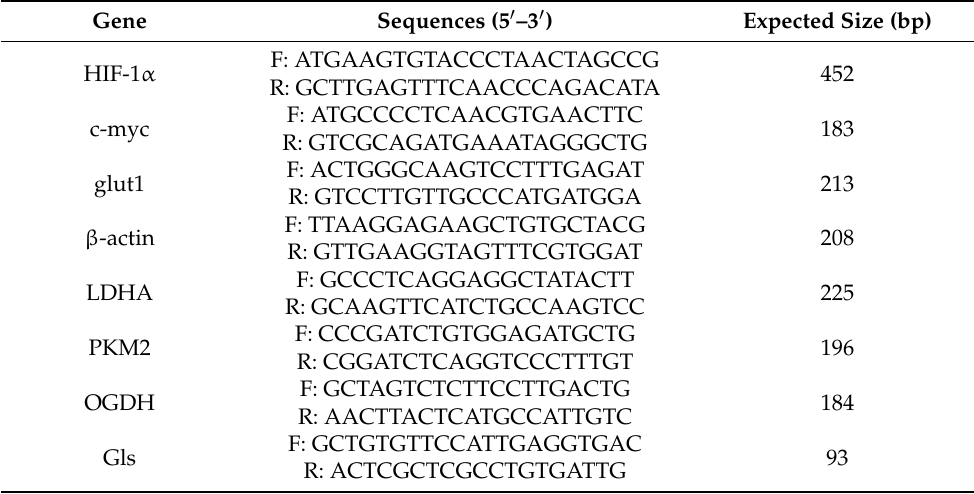
Table 1. Primers used in this